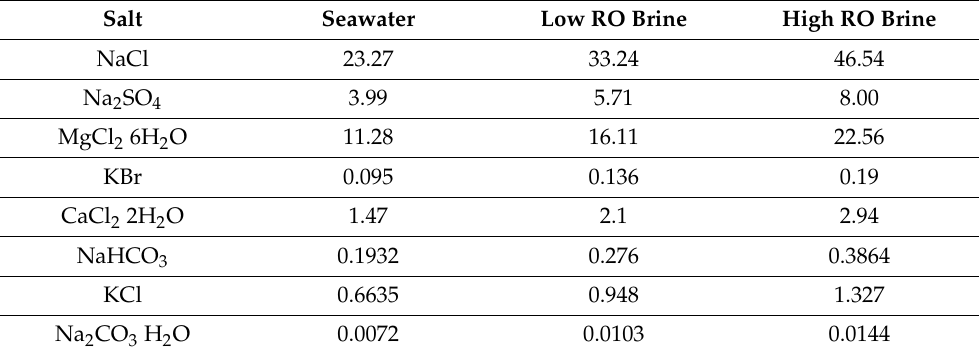
Table 1. Composition of the feeds (g/L) used in MD